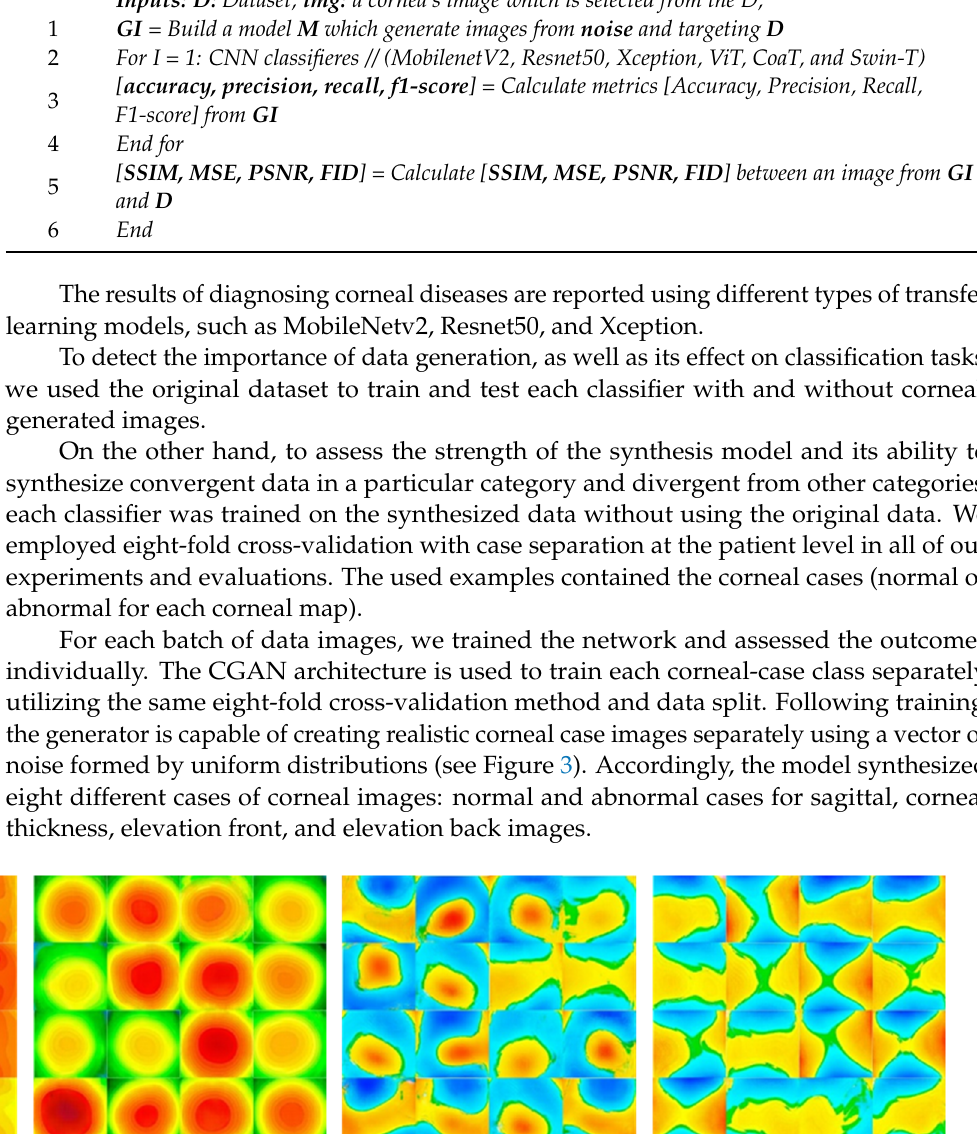
Table 3. Performance comparison for classifying corneal conditions among obstetric models after balancing data (%).